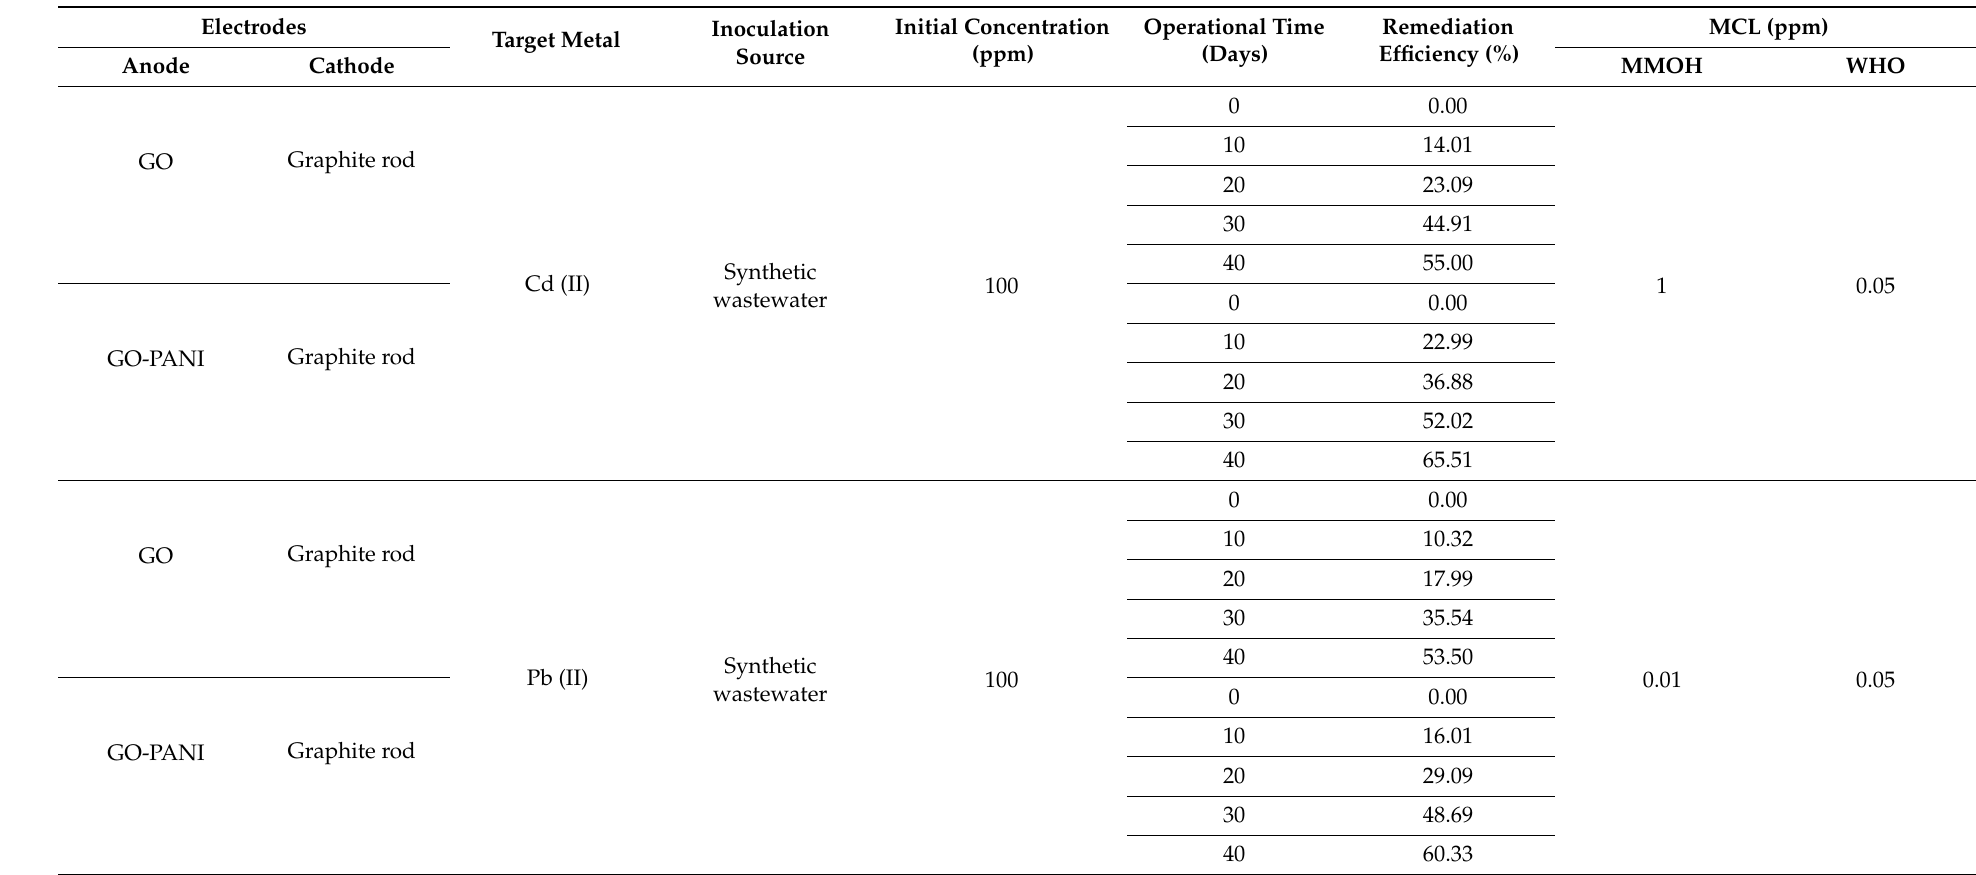
Table 3. Bioremediating efficiency of prepared anodes for metal ions from synthetic wastewater via BMFCs energized by local sweet potato